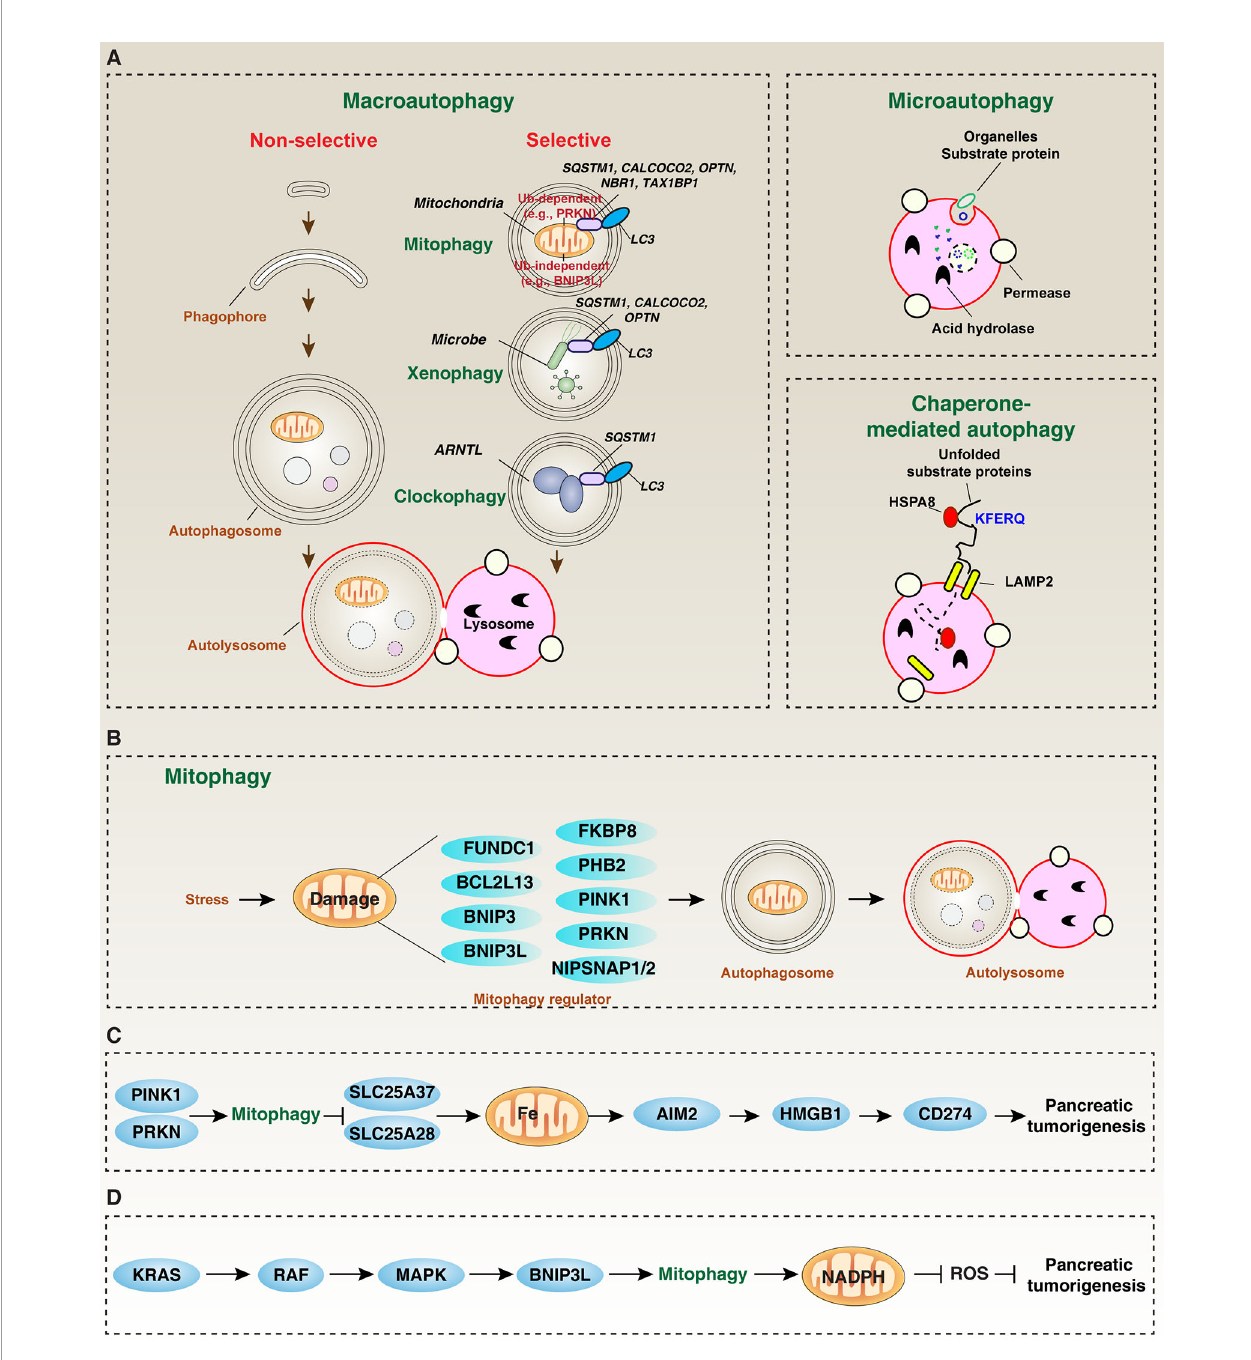
FIGURE 1 | The role of mitophagy in pancreatic tumorigenesis. (A) In mammalian cells, there are three main types of autophagy: microautophagy, macroautophagy, and chaperone-mediated autophagy. Macroautophagy can be further divided into selective and non-selective forms. (B) Core mitophagy regulators mediate mitochondrial clearance. (C, D) PINK1/PRKN and BNIP3L-dependent mitophagy play different roles in inhibiting or promoting pancreatic tumorigenesis,